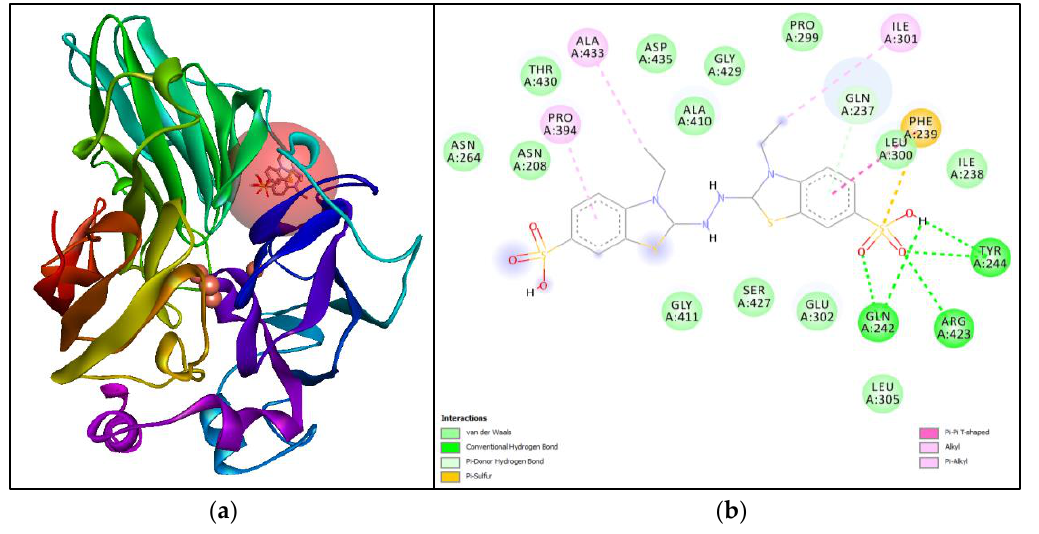
Figure 6. Molecular docking of ABTS and laccase; ( a ) the substrate is presented as stick and balls and the enzyme as solid ribbon and ( b ) two-dimensional diagram, the close aminoacid residues are presented in green, dashed lines represent intermolecular interactions of different origin (hydrogen bonds — green lines; π - π/π -cation stacking — pink/purple lines; van der Waals interactions and other hydrophobic forces — light green lines).